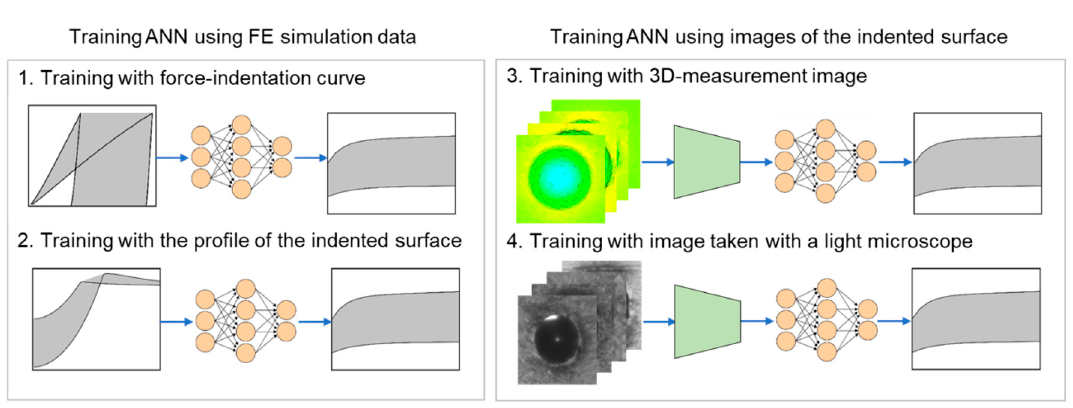
Table 1. Chemical compositions of used materials, in weight